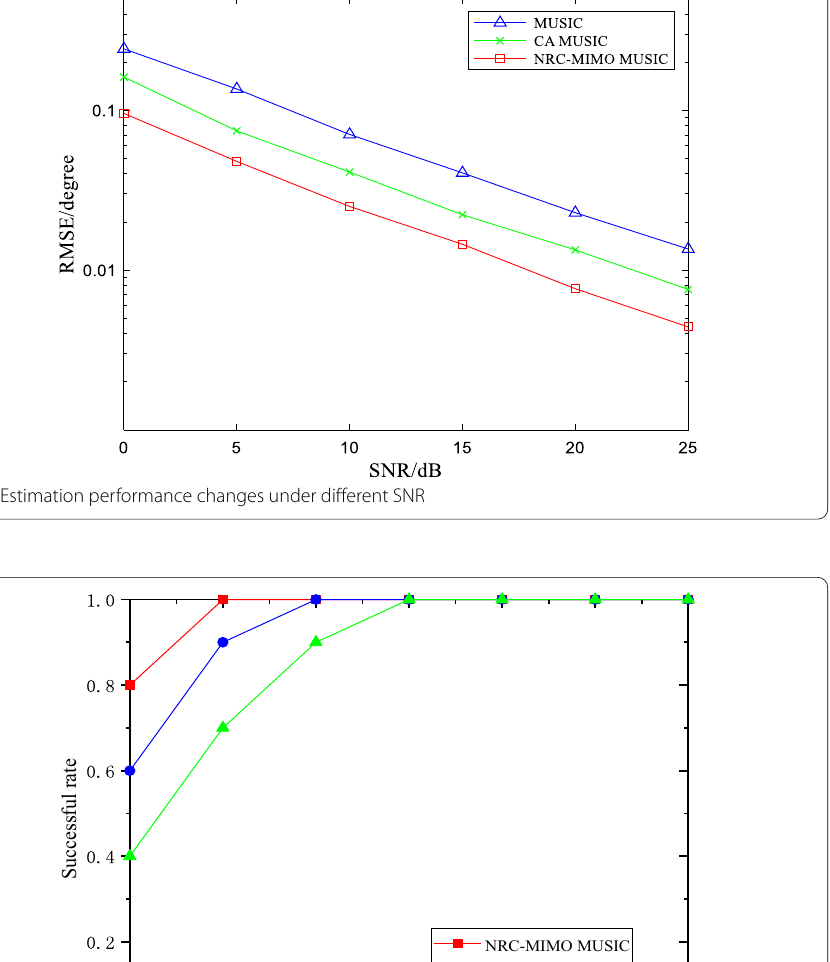
ality reduction MUSIC algorithm under 100 effective computer simulation experiments,